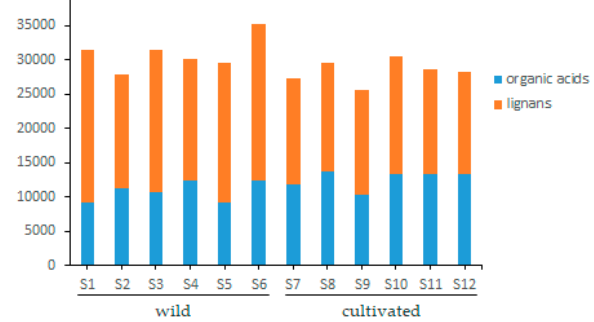
Figure 2. Histogram of the mean accumulative contents of different types of wuweizi from 12 batches.